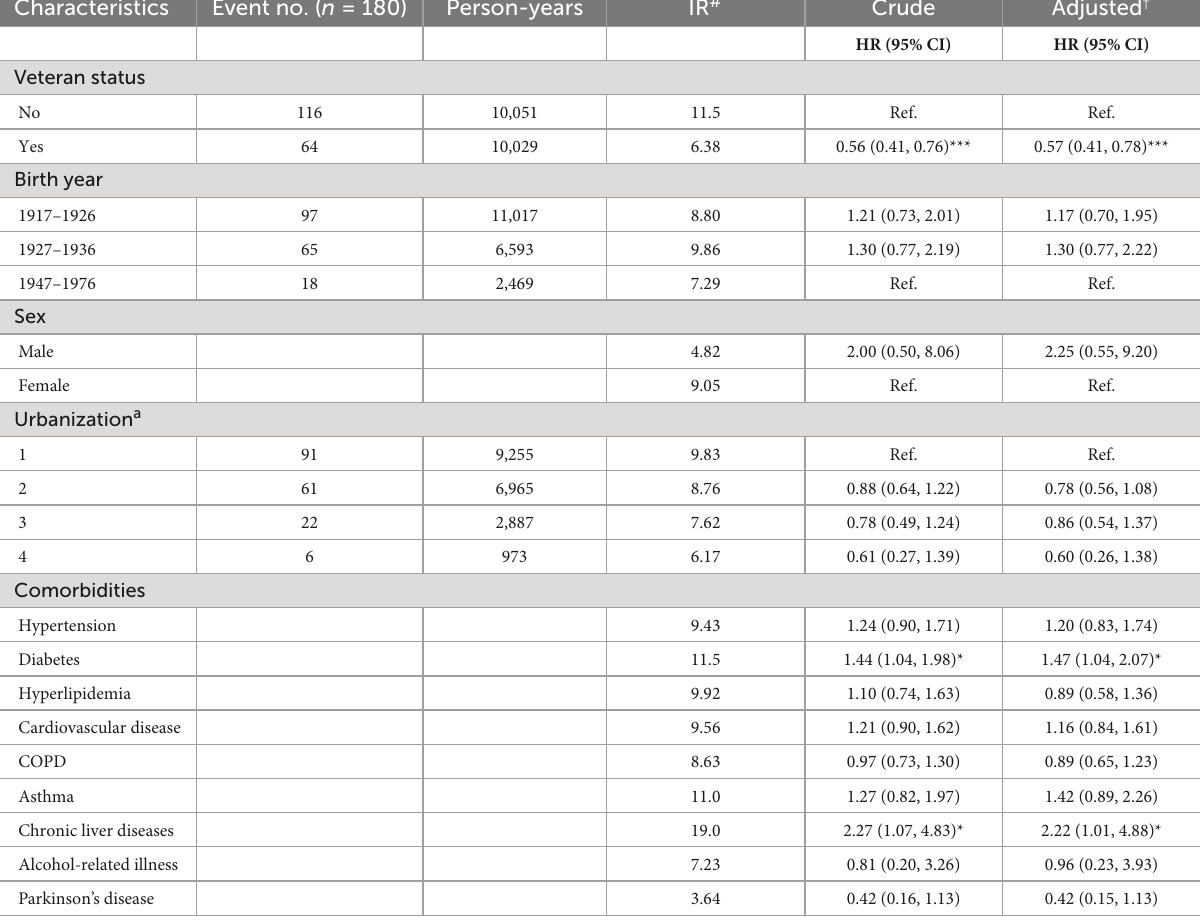
TABLE 2 Cox model measured hazard ratio and 95% confidence intervals of cancer associated with and without veteran status and covariates on the propensity score matched cohorts.